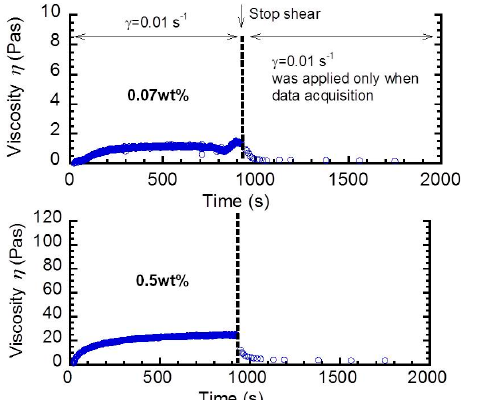
Table 1. Storage modulus for sacran aqueous solution with various concentrations: G’ A : before shear; G’ B : after shear; G’ C : after recovery. Sacran Concentration (wt.%)